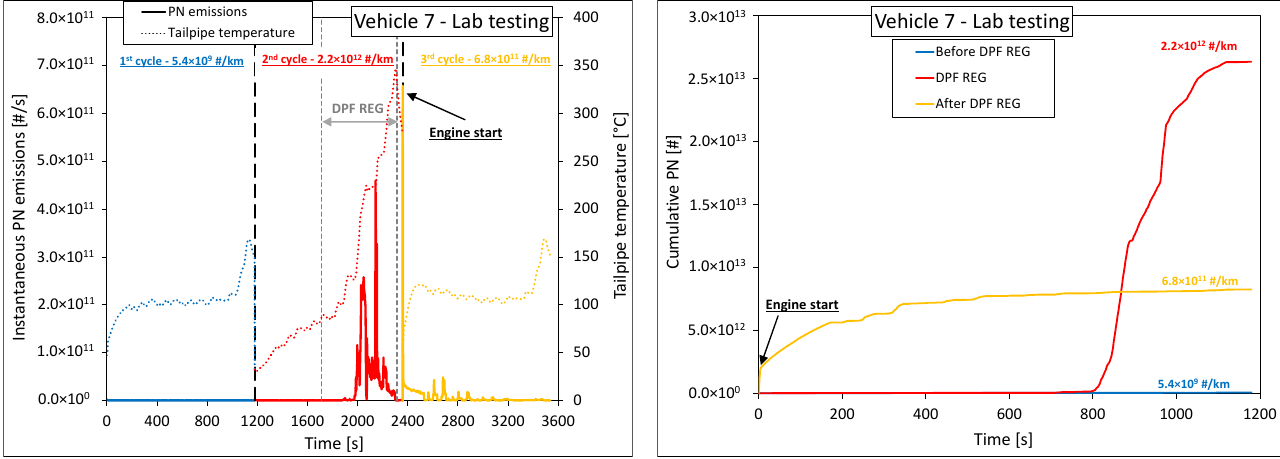
Figure 7. Instantaneous ( left ) and cumulative ( right ) PN emissions before, during and immediately after DPF regeneration.